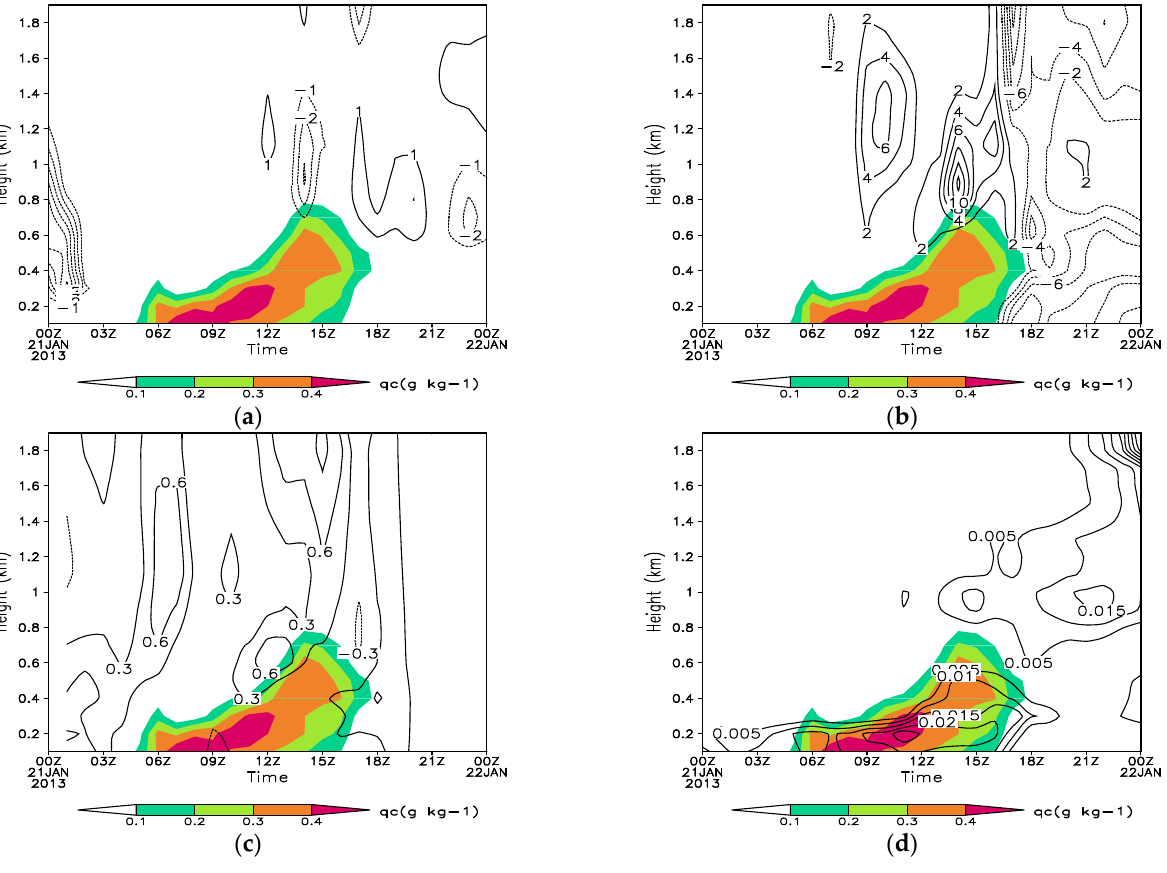
Figure 5. Regional average time series of contribution of three effects to relative humidity (contour, units: × 10 -5 s − 1 ) in the northern Yellow Sea: ( a ) advection effect in U-direction, ( b ) advection effect in V-direction, ( c ) radiation effect, and ( d ) turbulence effect (shading: cloud water mixing ratio, units: g kg − 1 ).